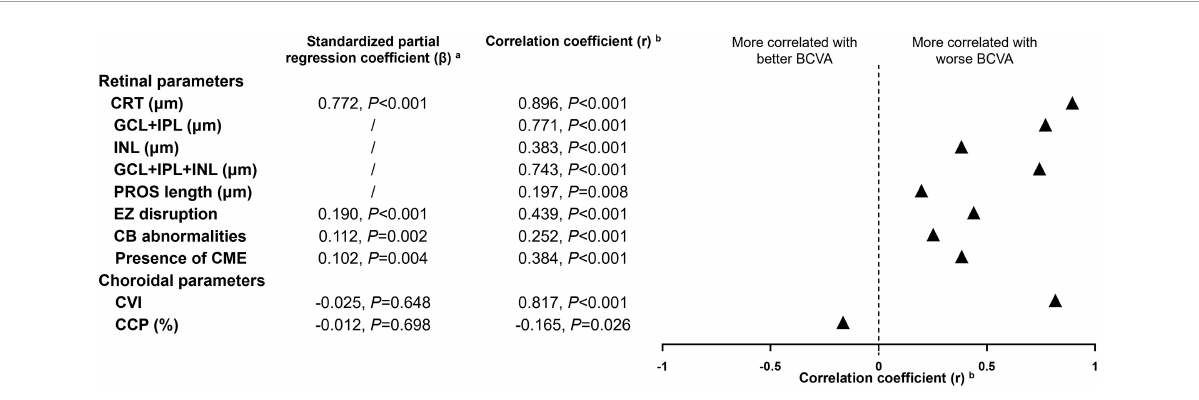
FIGURE3 Multiple regression and correlation analysis to determine the OCT morphologic factors related to best-corrected visual acuity in idiopathic epiretinal membranes. CRT, central retinal thickness; CME, cystoid macular edema; GCL + IPL, ganglion cell layer + inner plexiform layer; INL, inner nuclear layer; EZ, ellipsoid zone; CB, central bouquet; PROS, photoreceptor outer segment; CVI, choroidal vascularity index; CCP, choroidal capillary perfusion; BCVA, best corrected visual acuity. a OCT parameters with statistically solid and integral values across four stages of idiopathic epiretinal membranes were included in multiple regression analysis, which ruled out thickness of specific retinal layer for the disrupted retinal structure in higher stages of iERMs. Subfoveal choroidal thickness and choroidal area parameters were also excluded for their comparable value among four groups and lack of correlation to BCVA. b Spearman correlation analysis was used for continuous variables and Kendall’s tau-b correlation analysis was used for categorical